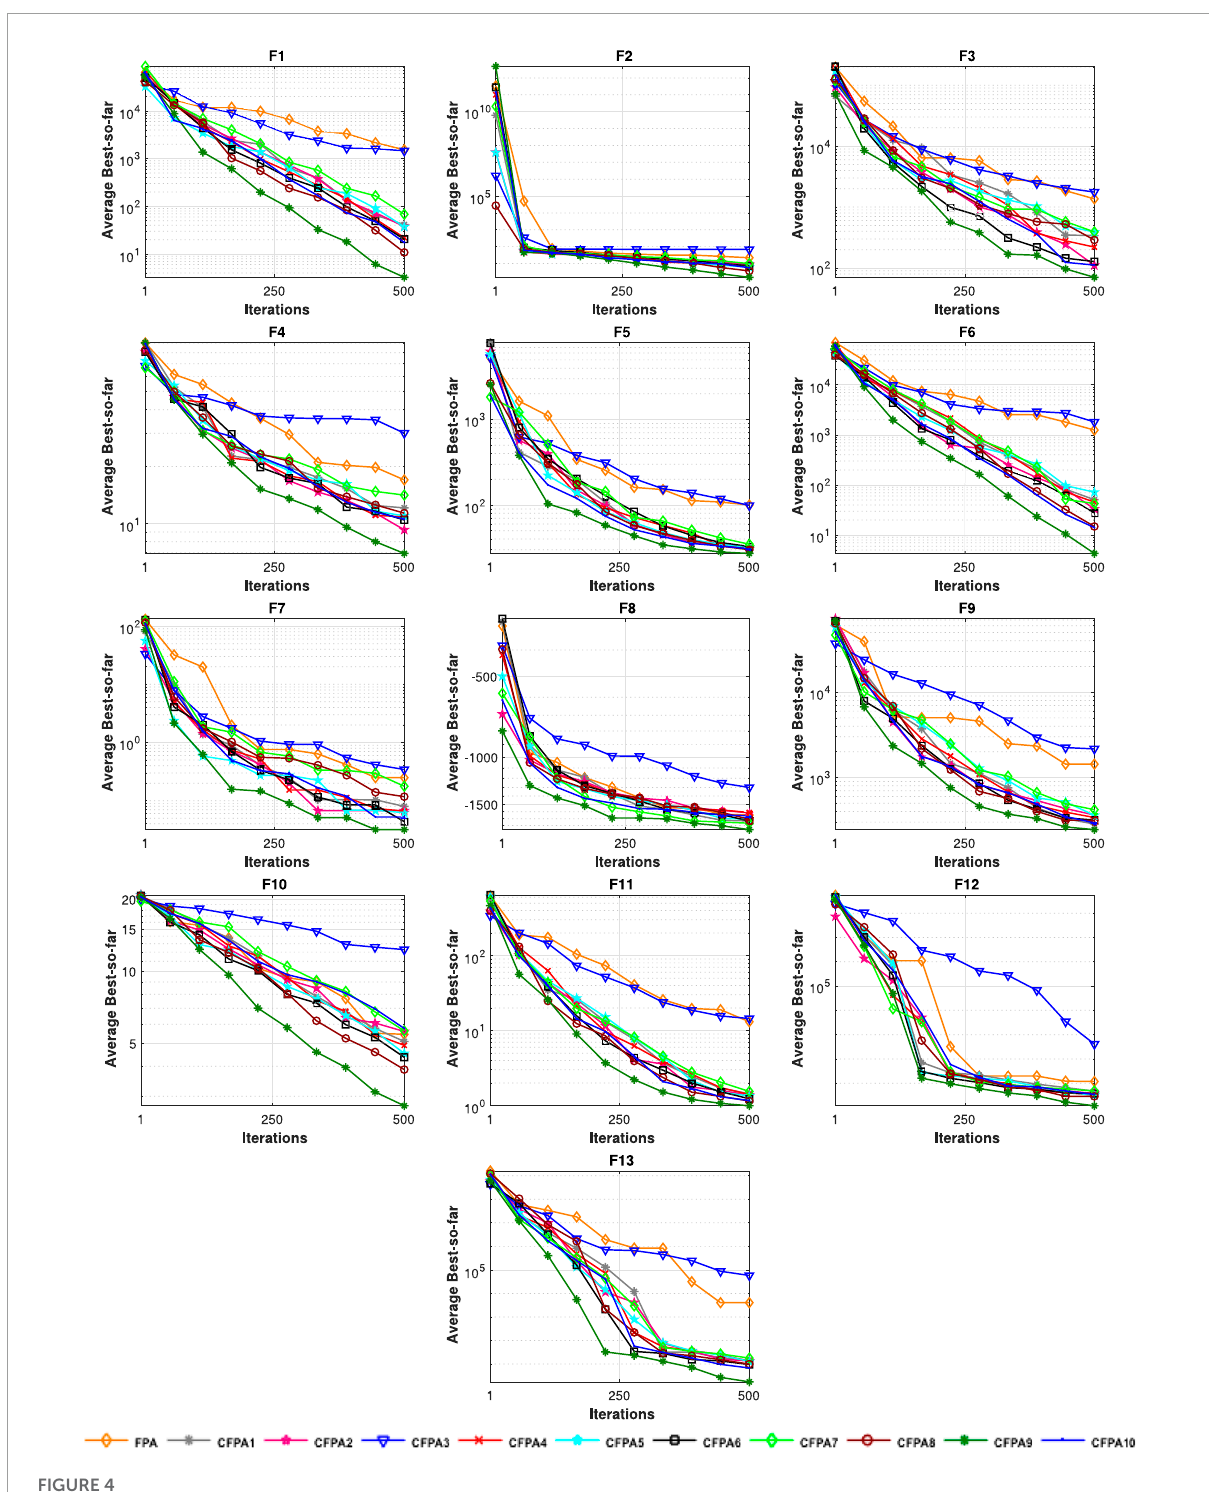
FIGURE 4 Convergence curves for chaotic FPAs on benchmark